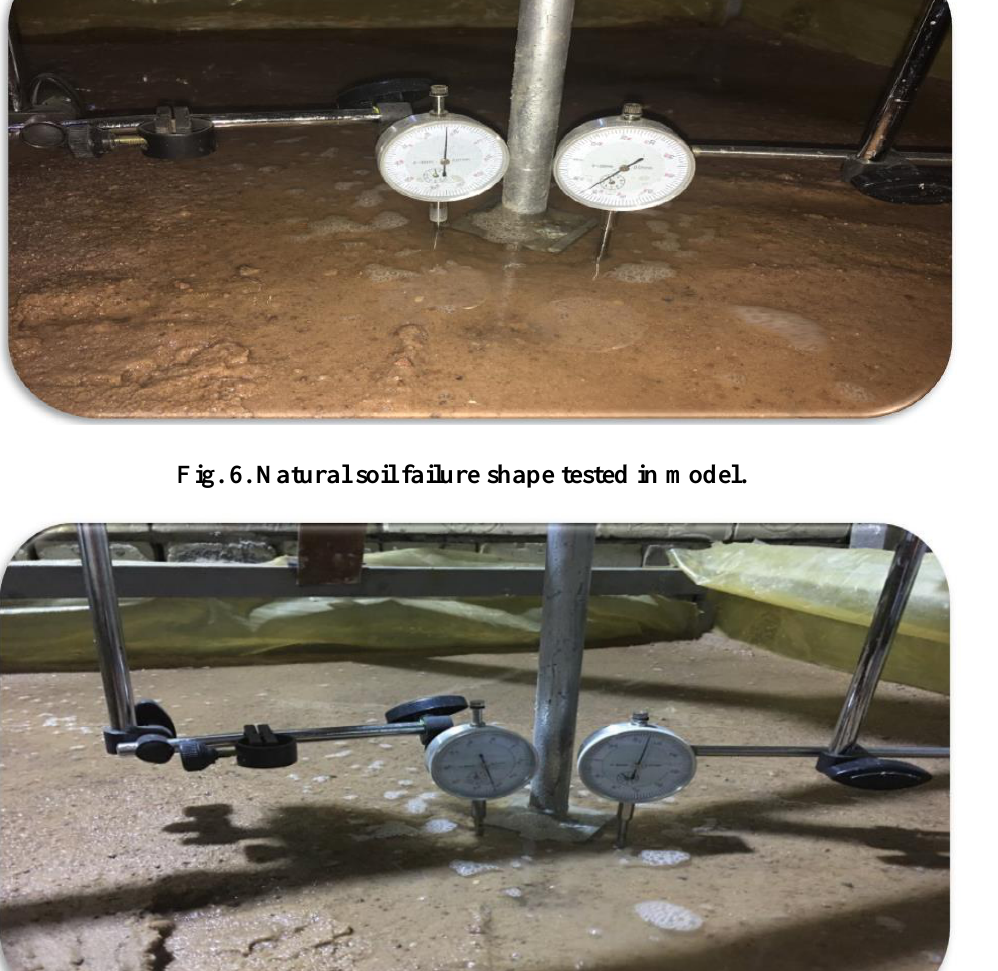
Fig. 7. Failure shape of the natural soil loaded in soaked